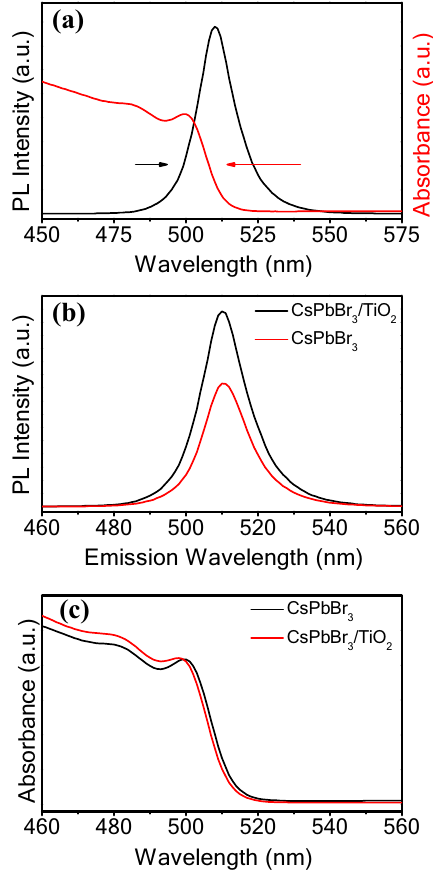
Fig. 3 a PL spectra and optical absorption spectra of CsPbBr nanocomposites. b PL spectra of CsPbBr